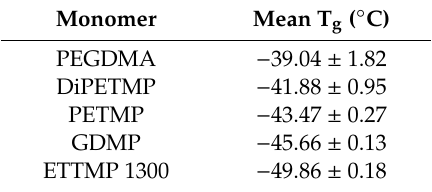
Table 3. The glass transition temperatures of thiolated PEGDMA hydrogels (n = 2).